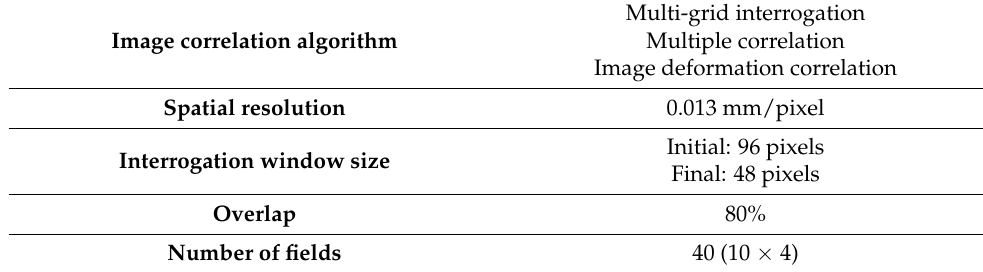
Figure 6. System for the BOS density field measurement. Table 2. Conditions for the displacement field calculation.